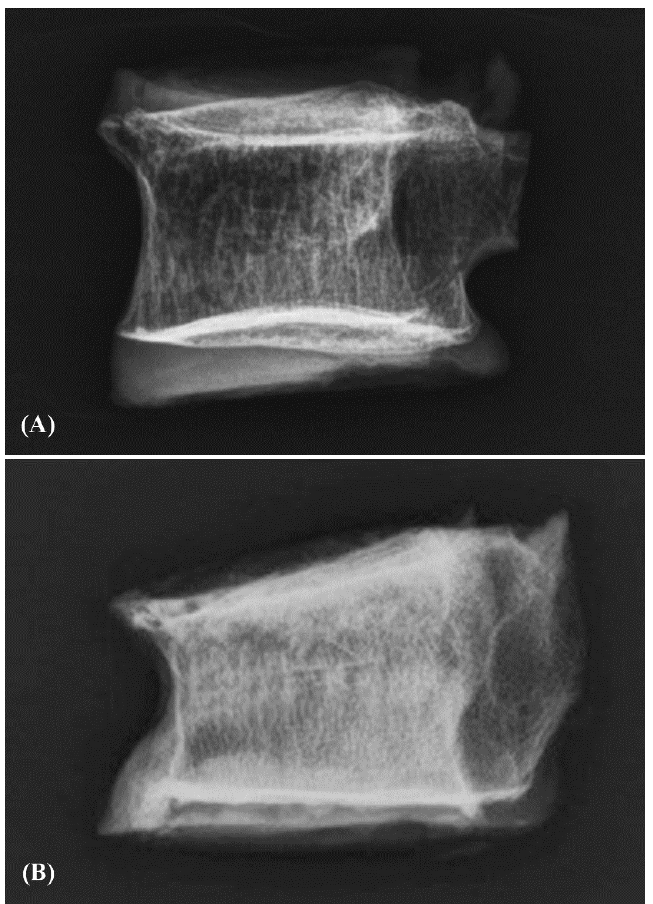
Figure 4. Photograph showing the vertebra ( A ) before and ( B ) after the creation of anterior wedge compression fracture. Anterior wedge fractures were created without posterior wall destruction.